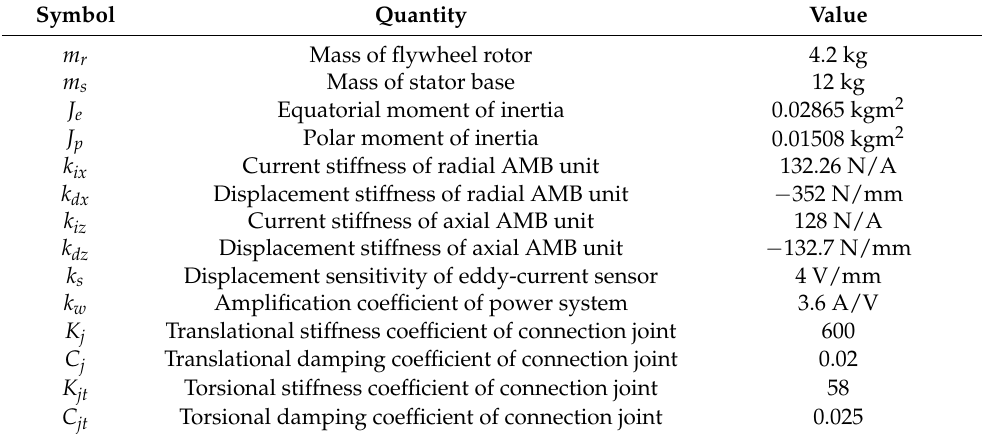
Table 1. The system parameters of the 5-DoF